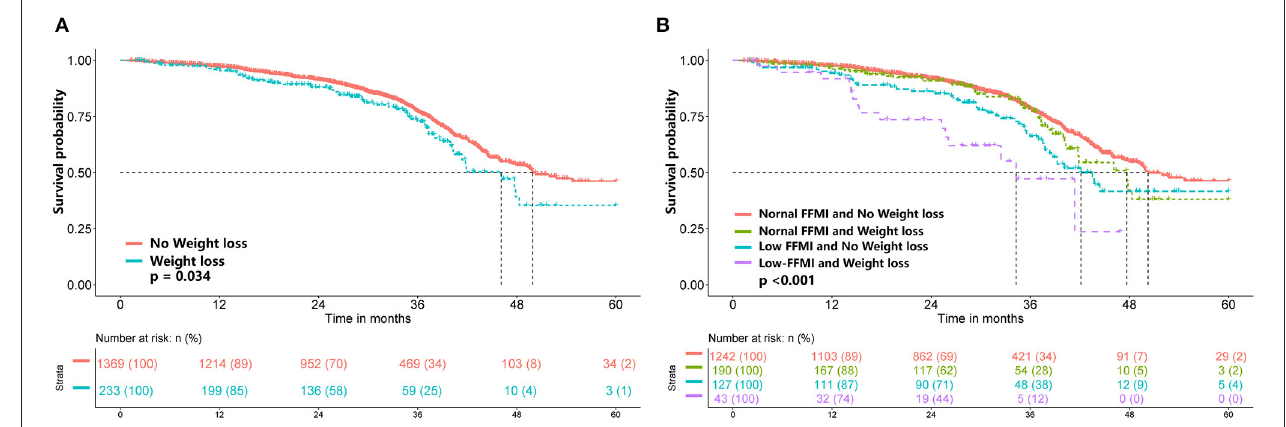
FIGURE 4 | Kaplan-Meier survival analysis of weight loss (A) and FFMI combined with weight loss (B) . FFMI, fat free mass